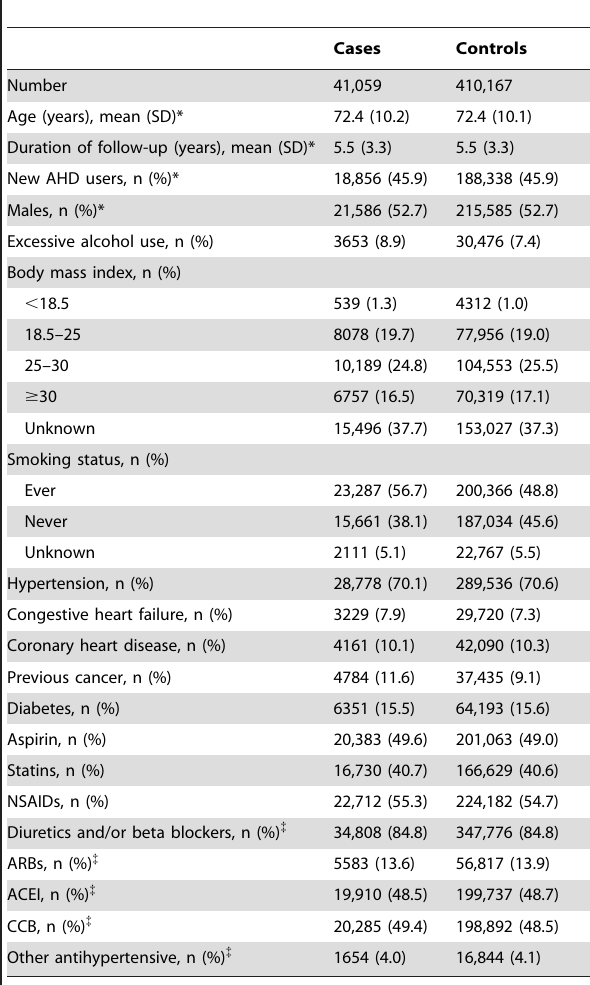
Table 1. Characteristics of cases and matched controls